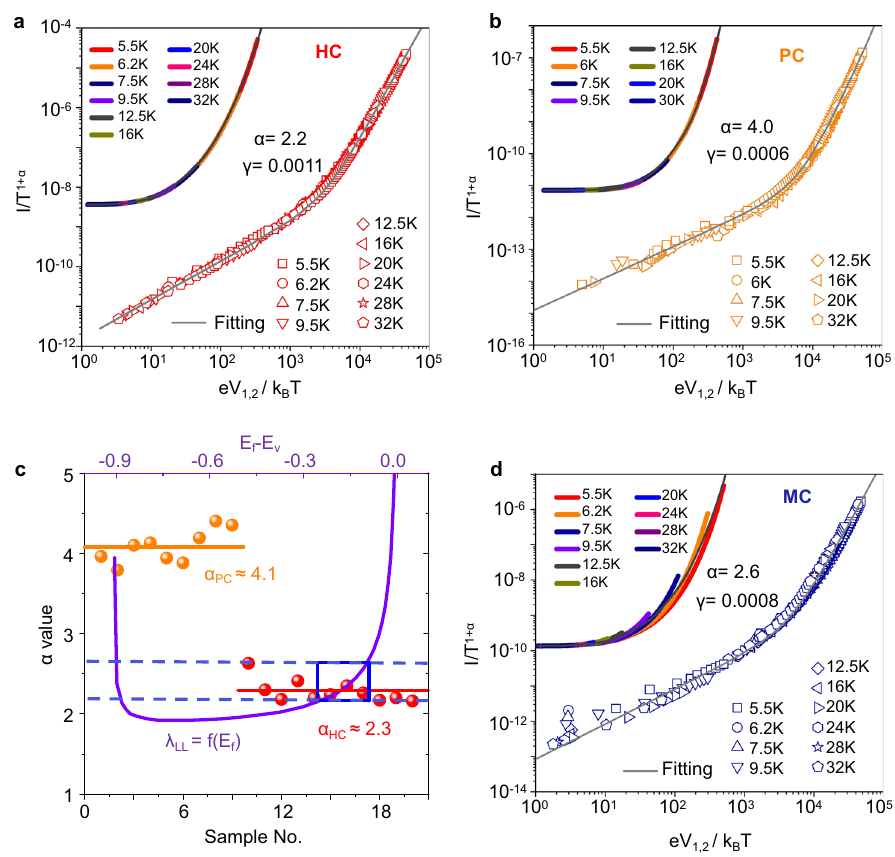
Fig. 4 Correlation of transport parameters. Fitting between I(V, T) and the curves depicted by Eq. (1), for HC sample ( a ) and PC sample ( b ), which are displayed in double logarithmic coordinates. Parameters α , and γ are obtained via the fi ttings, and the upper-left part in the panel displays the I(V, T) curves in linear coordinates. c The distribution of the exponent α values extracted from several nonlinear curves from HC (red) and PC (orange) samples. The violet curve denotes the theoretic evaluated power-law exponent λ LL for quasi-1D polymer chains, which is dependent on the position of the Fermi level, and equals to the experimental extracted α HC ’ value. The system carrier density is evaluated with the values of α HC to λ LL as the blue orthogon noted. d Fitting between I (V, T) and the curves depicted by Eq. (1) for the MC sample. The experimental data are more clearly identi fi ed within the linear coordinates as shown in the upper-left part in the